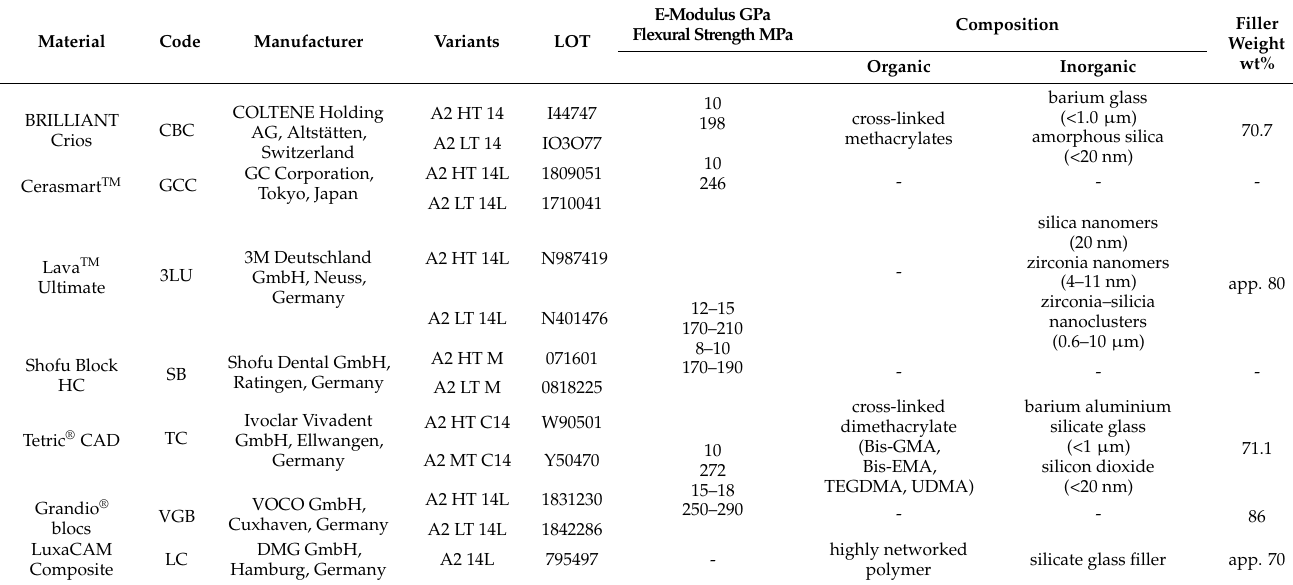
Table 1. Information on composition and weight of the CAD/CAM resin-based composite (RBC) blocks analysed in the current study as specified by the manufacturer; mechanical properties based on manufacturer and Rosentritt et al.